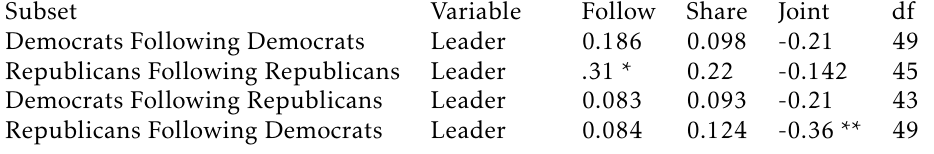
Table 5. Correlation between Network Centrality and Leadership position for party subsets Subset Variable